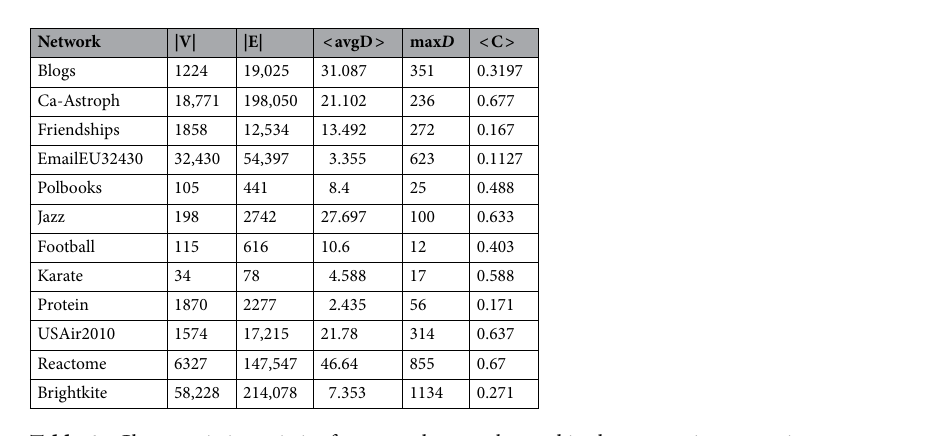
Table 6. Characteristic statistics for ten real networks used in the comparison experiment.